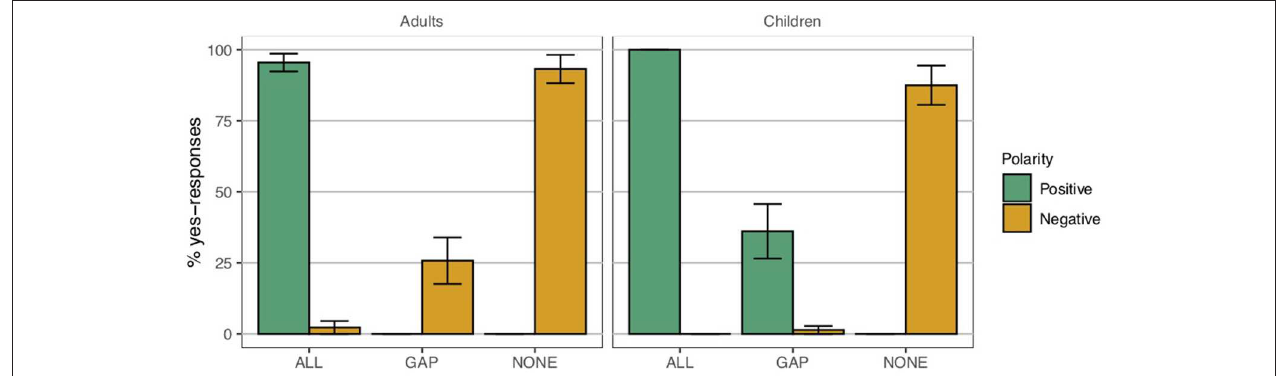
FIGURE 6 | Percentage of yes -responses to the plural definite description targets and controls. Error bars correspond to the standard error of the within-participant means. Homogeneity targets corresponded to plural definite descriptions of GAP contexts. Clearly true controls corresponded to positive plural definite descriptions of ALL contexts and negative plural definite descriptions of NONE contexts. Clearly false controls corresponded to positive plural definite descriptions of NONE contexts and negative plural definite descriptions of ALL contexts.